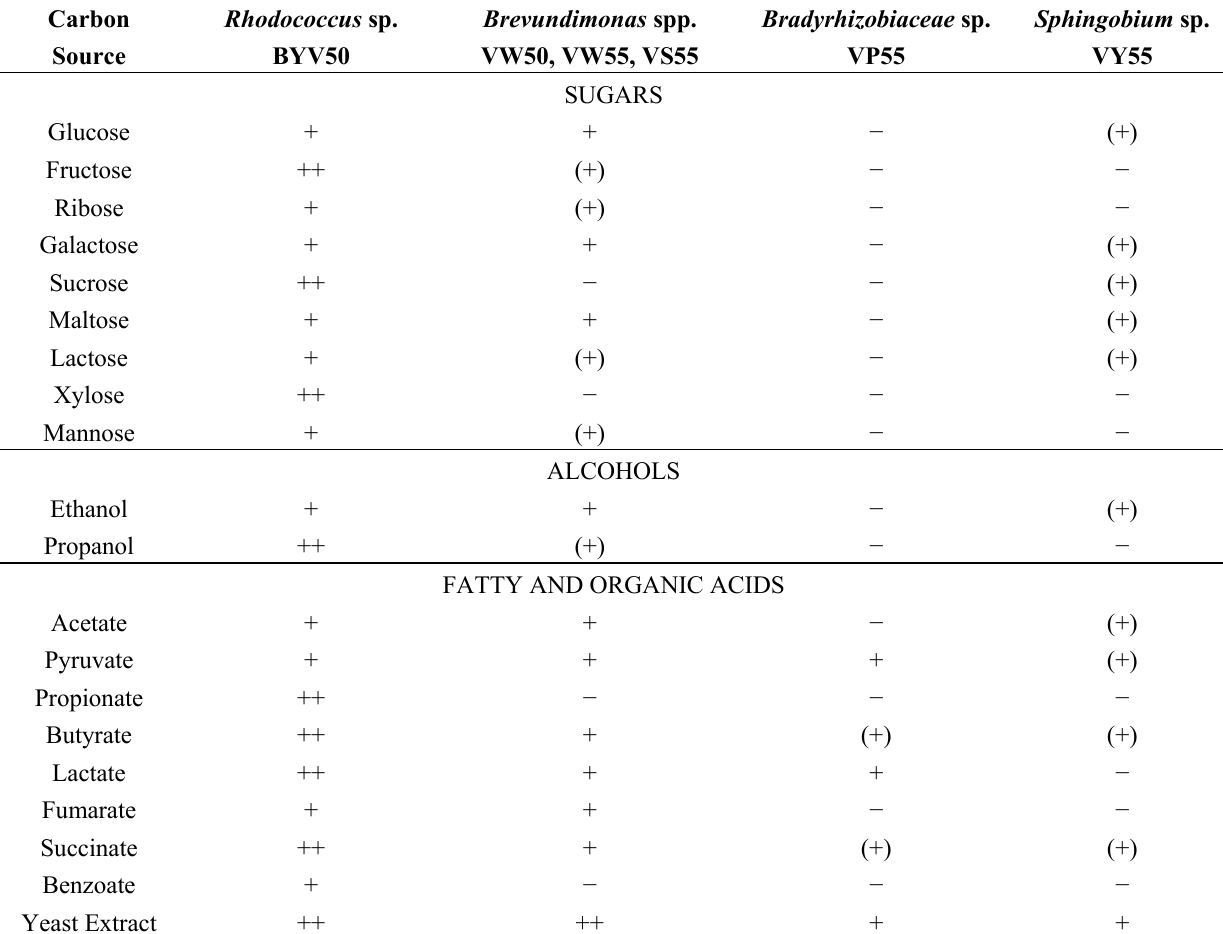
Table 2. Carbon source utilization by Lake Vanda bacteria isolated in this study a .